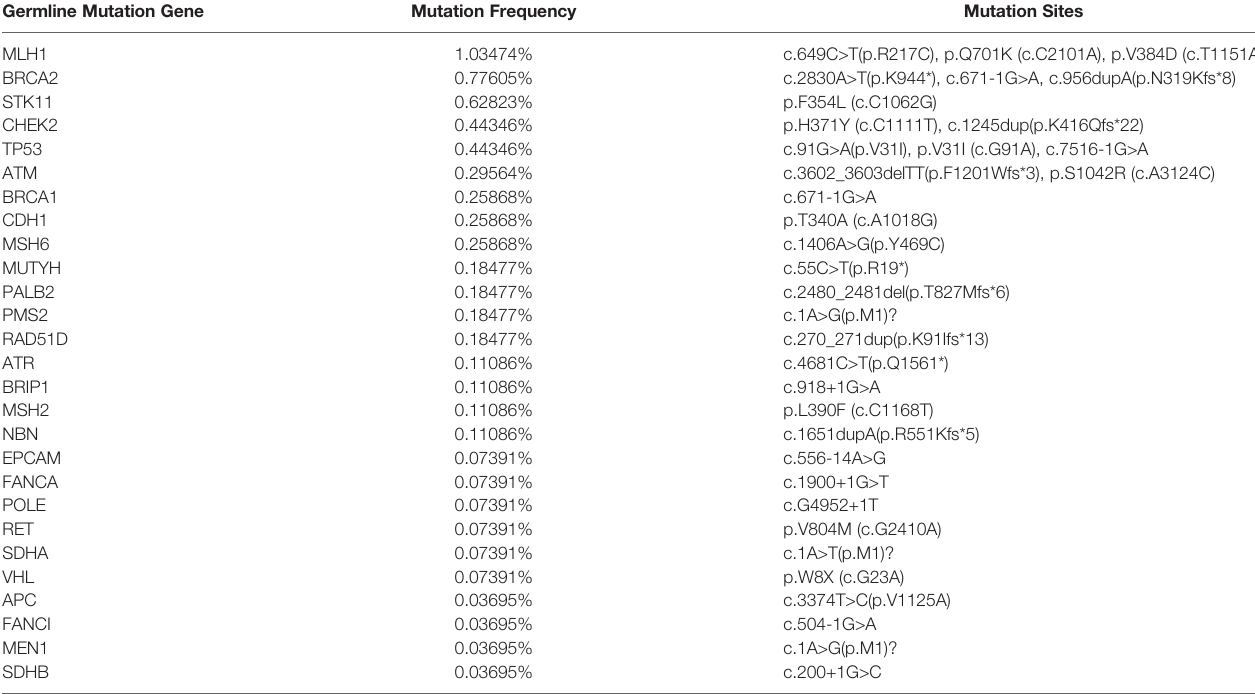
Supplementary Figure 1 | Somatic mutation spectrum of fi ve lesions in three patients. (A,B) SomaticSNV/INDELmutationspectrum; (C) SomaticCNVmutation